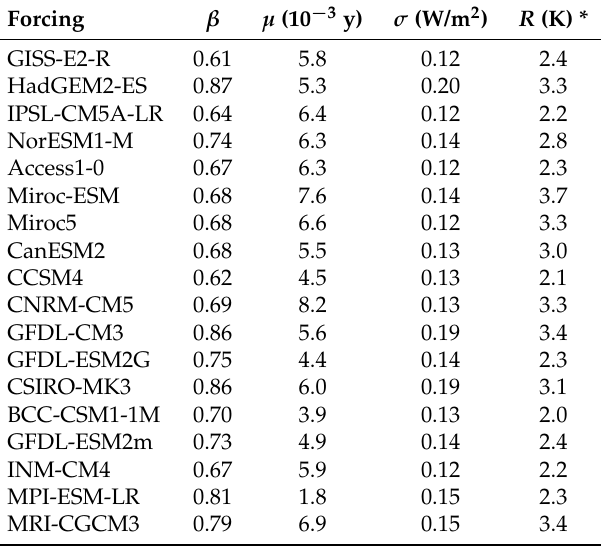
Table 2. The parameter estimates for the instrumental temperature record, and the resulting values of R , for varying forcing data.